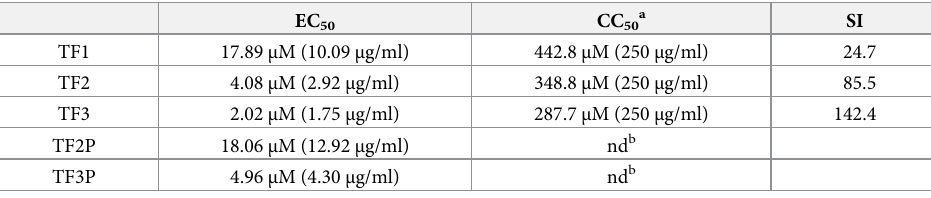
Table 1. EC 50 , CC 50 and SI of the different